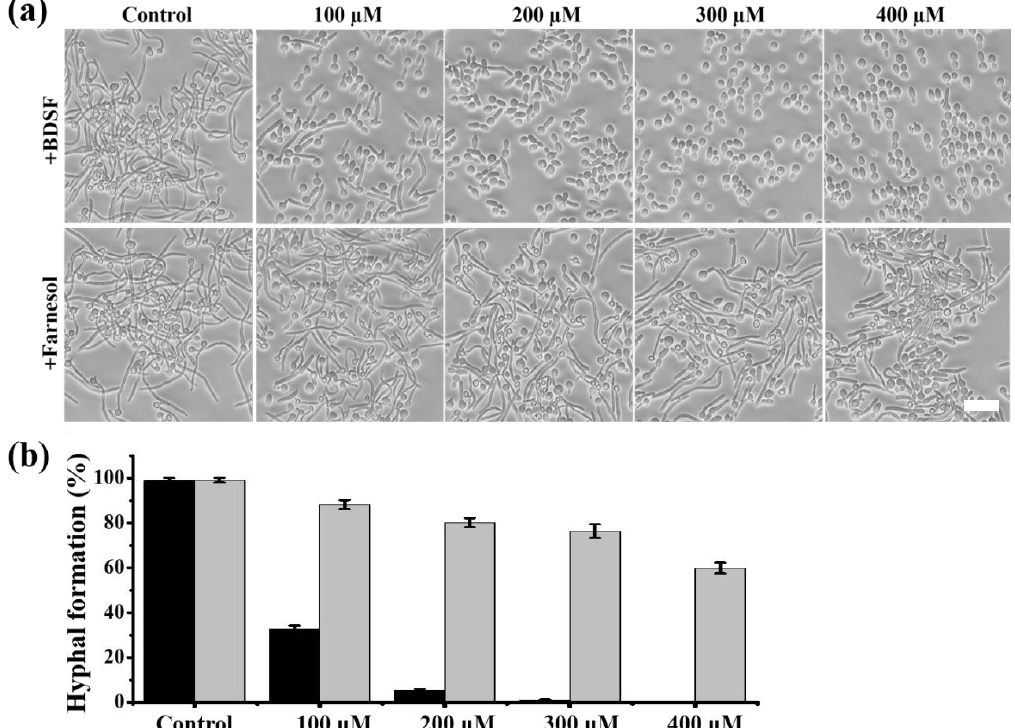
Figure 1. ( a ) Hyphal formation was induced in YPD medium (1% Difco yeast extract, 2%